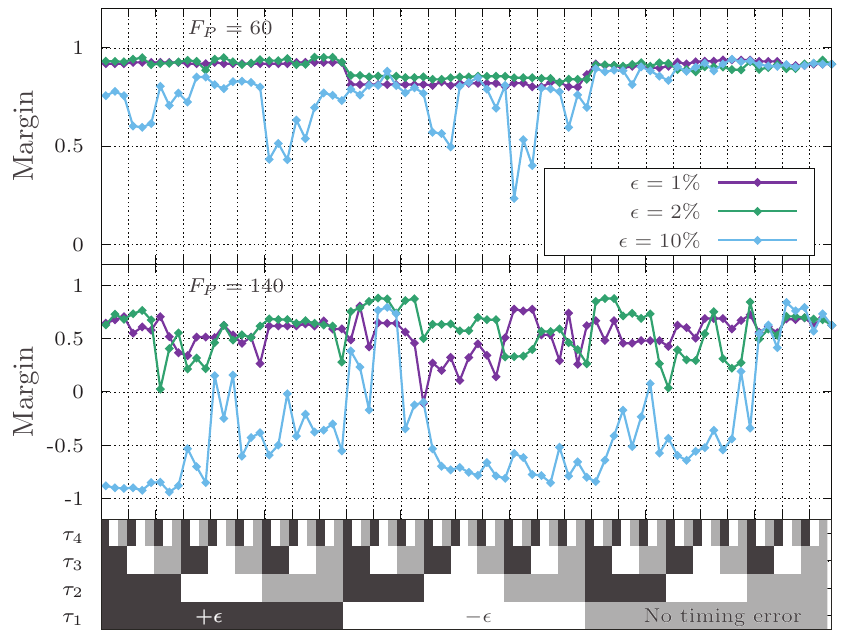
Figure 9. Margin as a function of timing error for F P = 60 and F P = 140 of line 3.2. τ 1 , τ 2 , τ 3 and τ 4 (cid:101) and 0) such that all 81 combinations of timing error are are cyclically varied across 3 conditions ( ± considered. The process is repeated for (cid:101) = 1%, 2% and